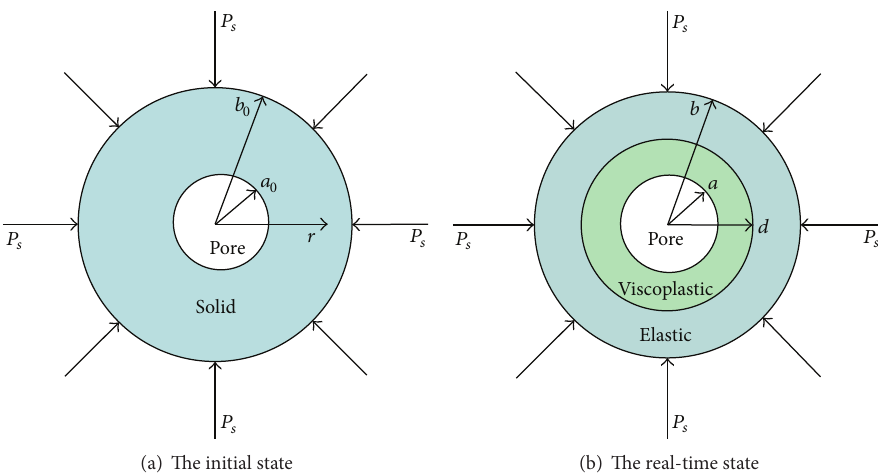
Figure 1: One-dimensional hollow spherical model for “hot-spots” formation ( 𝑑 denotes the boundary between elastic and viscoplastic flow).